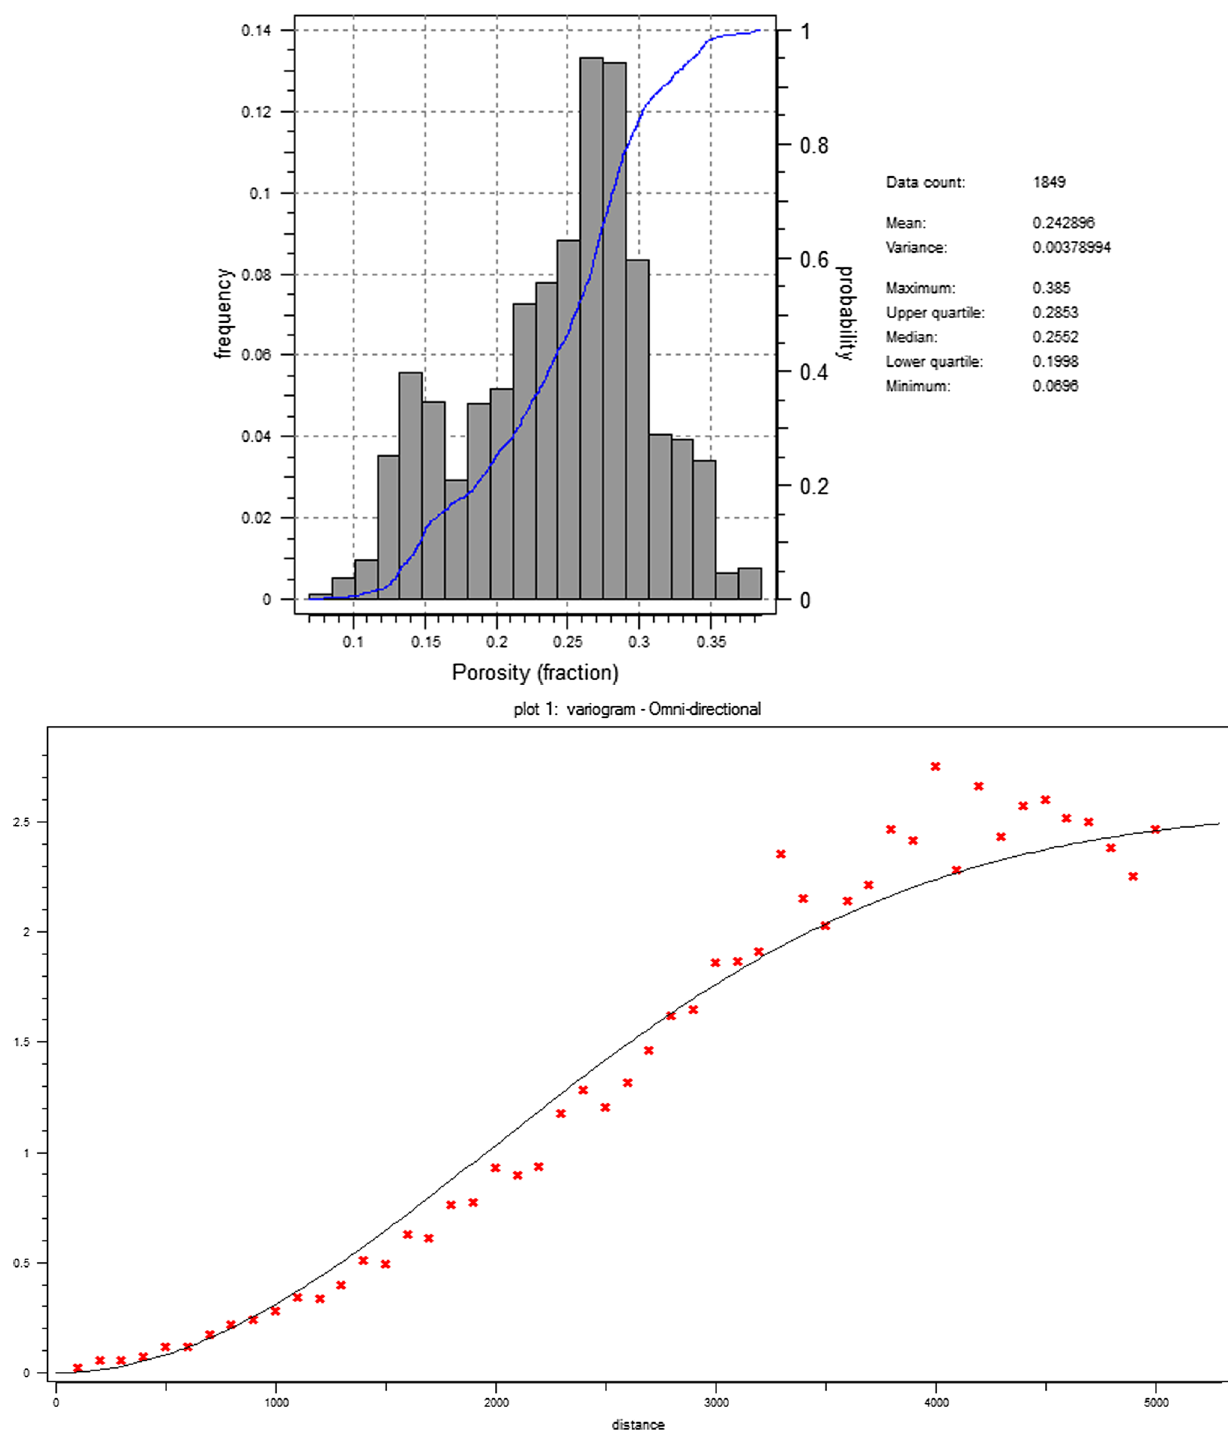
Fig. 3 Histogram and variogram for porosity across the